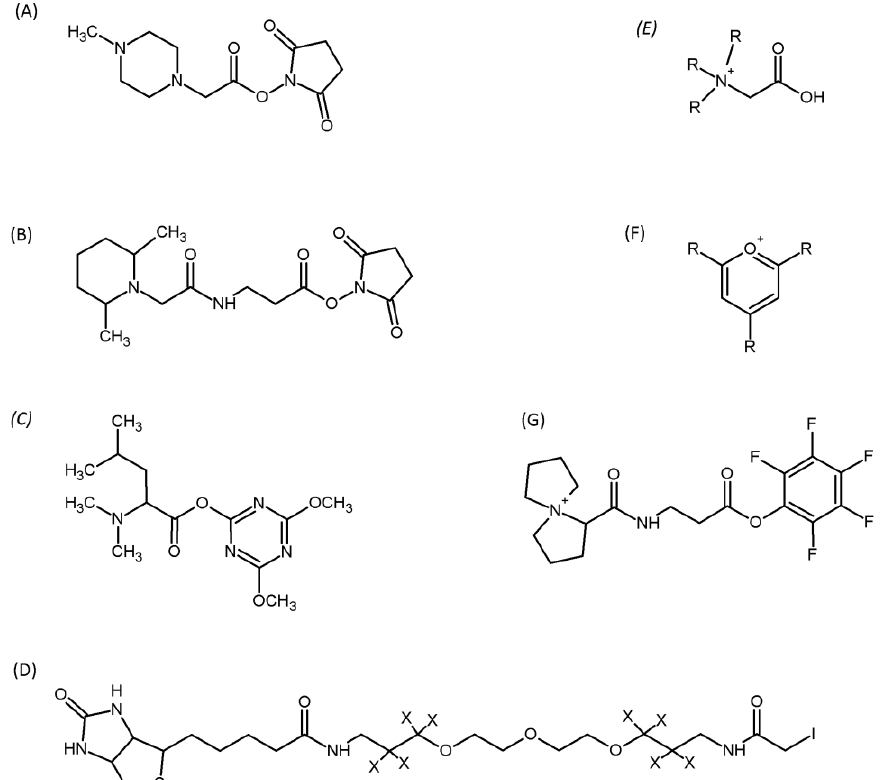
Figure 5. Exemplary structures of compounds used to modify peptides and proteins for their sensitive LC-MS analysis. ( A ) Isobaric tags for relative and absolute quantification (iTRAQ); ( B ) Tandem mass tags (TMTs); ( C ) N,N-dimethylleucine based tag; ( D ) Isotope Coded Affinity Tag (ICAT); ( E ) N,N,N-trialkylglycine; ( F ) 2,4,6-trisubtituted pyrylium salt; ( G ) 5-azoniaspiro[4.4]nonyl (ASN+) scaffold